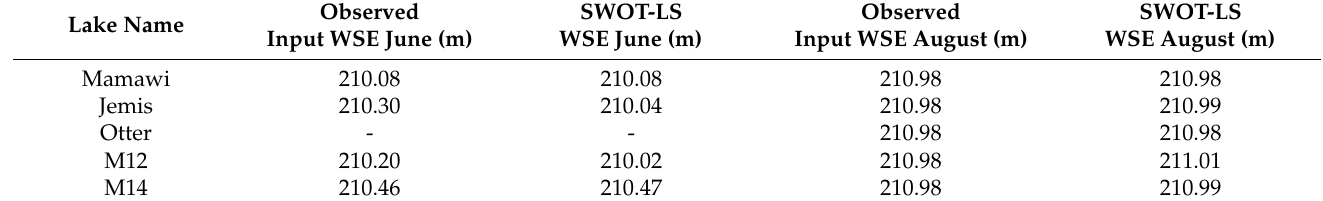
Table 4. WSE, WSA and Lake name of SWOT-LS simulated results for 10 June and 3 August.